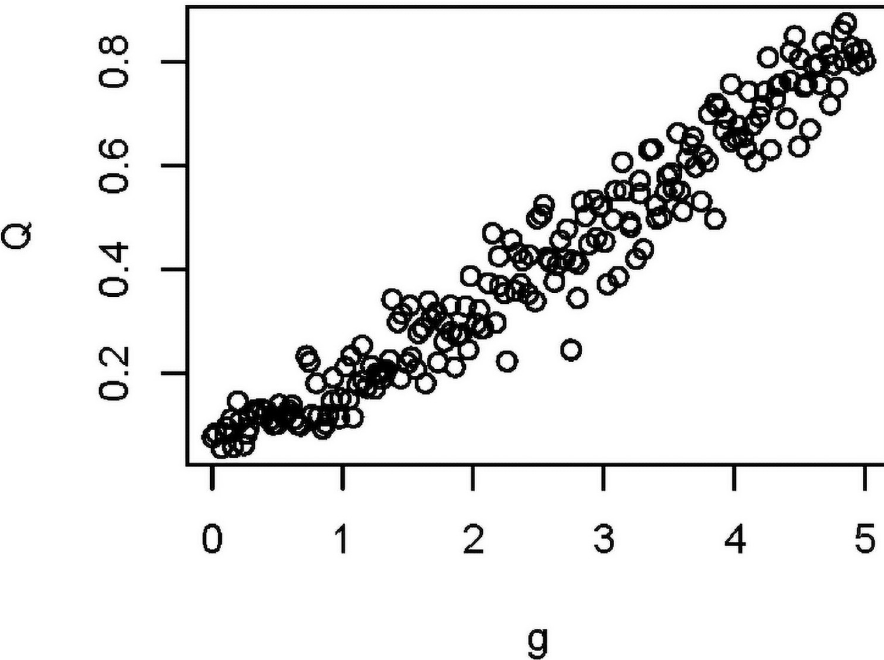
Fig 3. Effect of host specificity on Q. Simulations in which g was varied, holding all other parameters constant at their values in Table 1. A strong positive association was found (see text and Table 4).